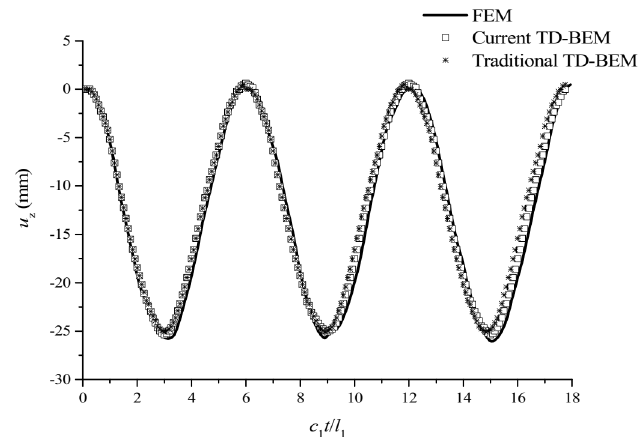
Figure 10. Sketch of the example of the restrained beam.